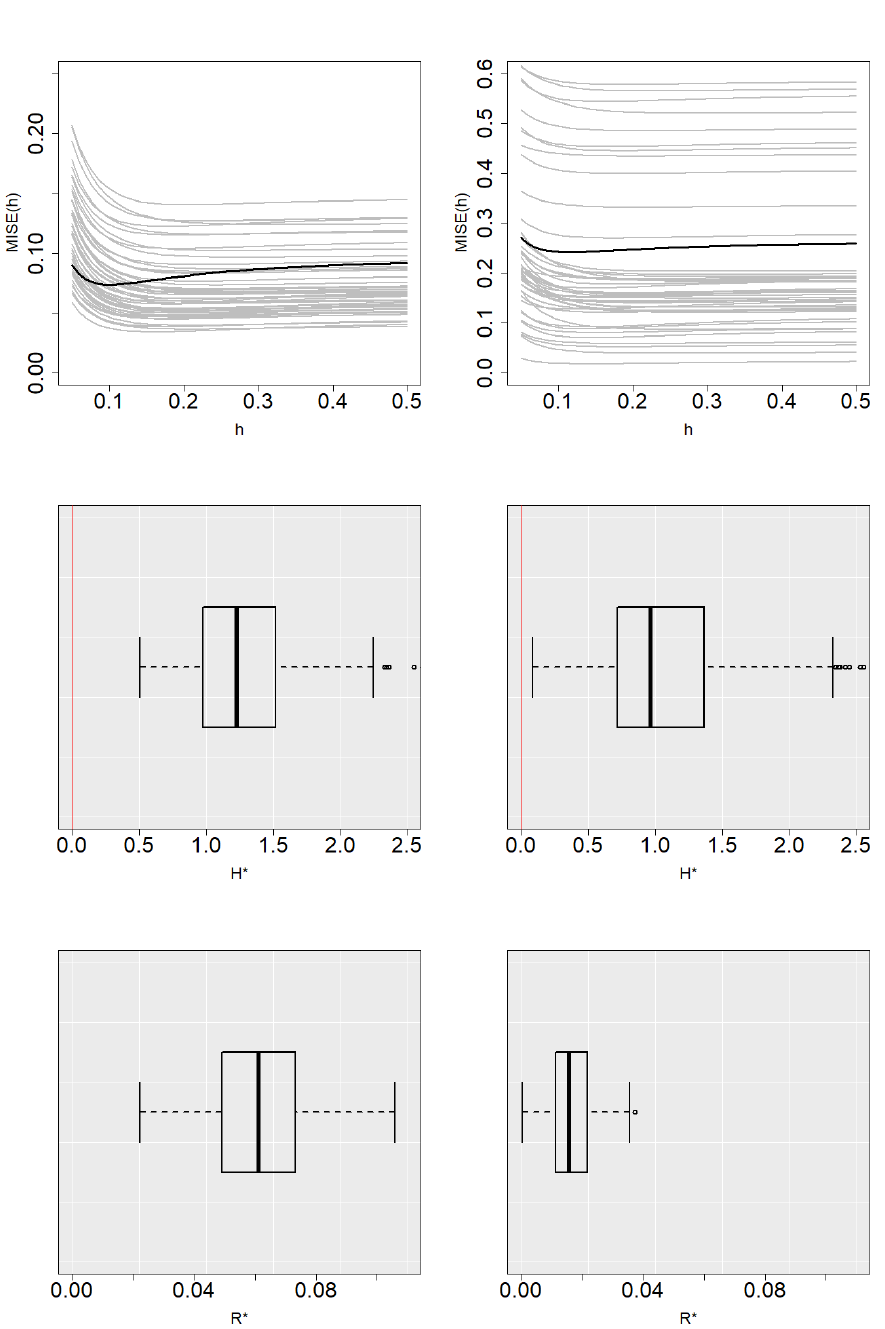
Figure 2. MISE x ( h ) function (black line) approximated via Monte Carlo and MISE ∗ x ( h ) functions (gray lines) for N = 300 samples ( top ), boxplot of H ∗ values ( bottom ) when the conditional probability of censoring is 0.2 ( left ) and 0.5 ( right ) in Model